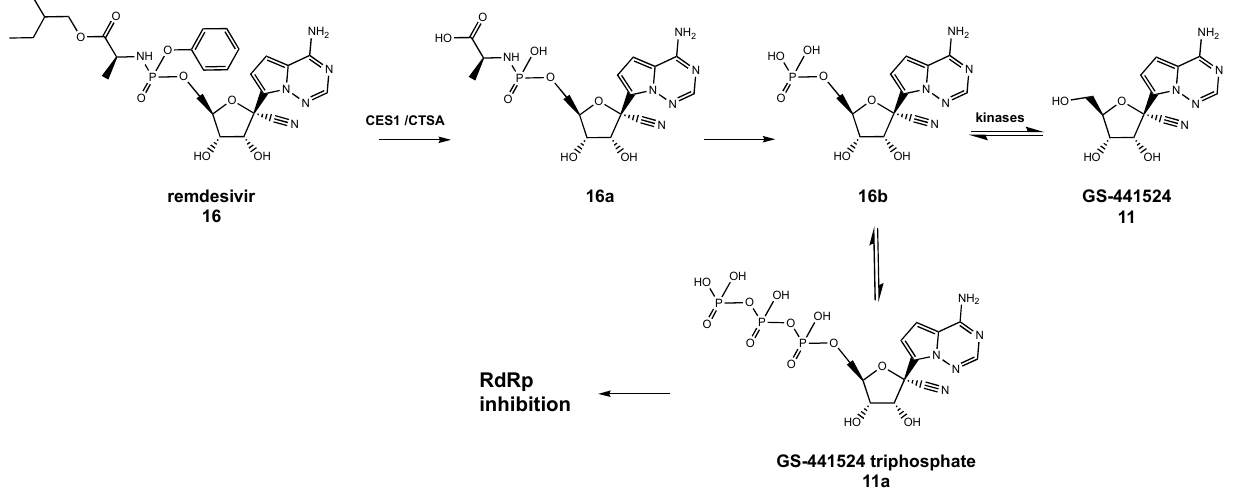
Figure 5. Mechanism of the RdRp inhibitory activity of remdesivir and its non-phosphorylated nucleoside form GS-441524.